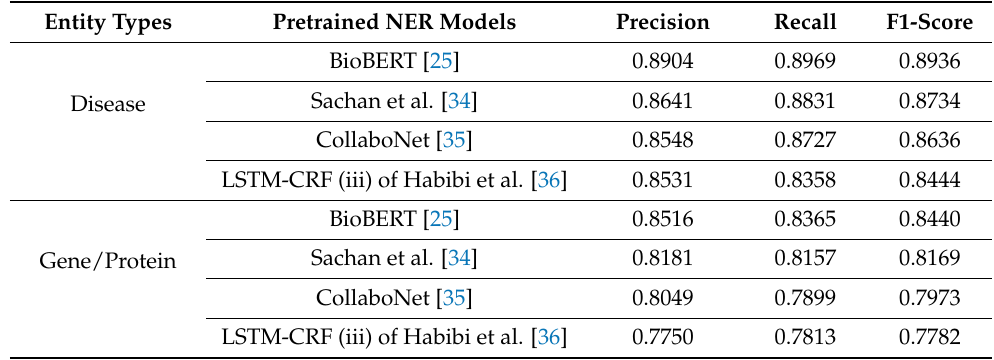
Table 2. Performance comparison of NER models for genes/proteins,